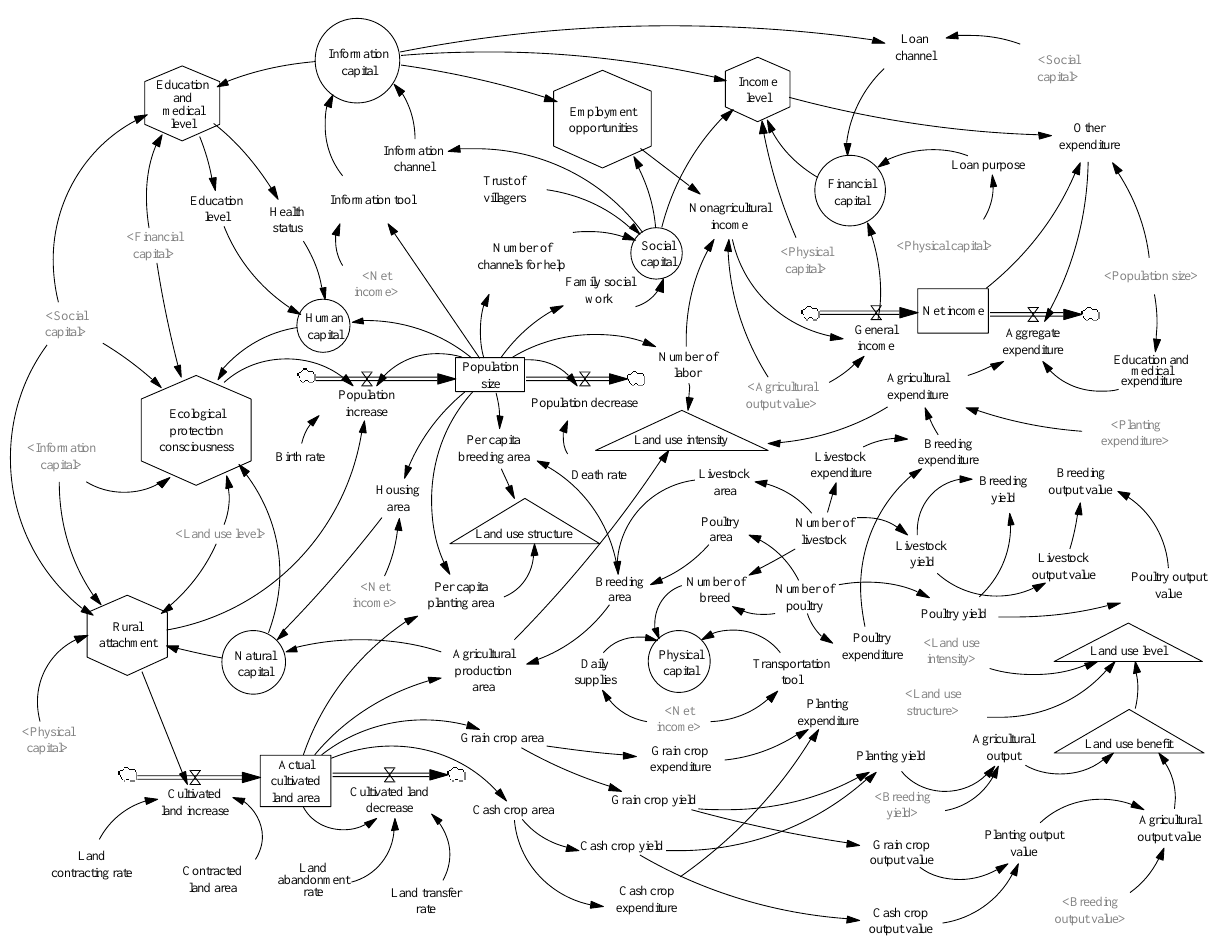
Figure 4. Flow stock diagram of the coupling system.